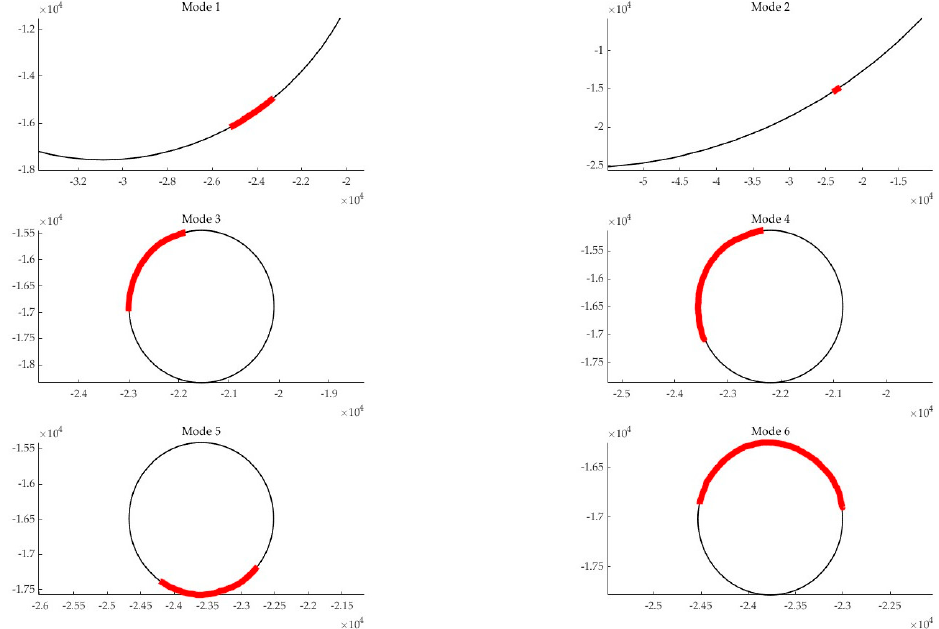
Figure 7. Fitting circle diagram of the driving track on the subsiding paddy field.